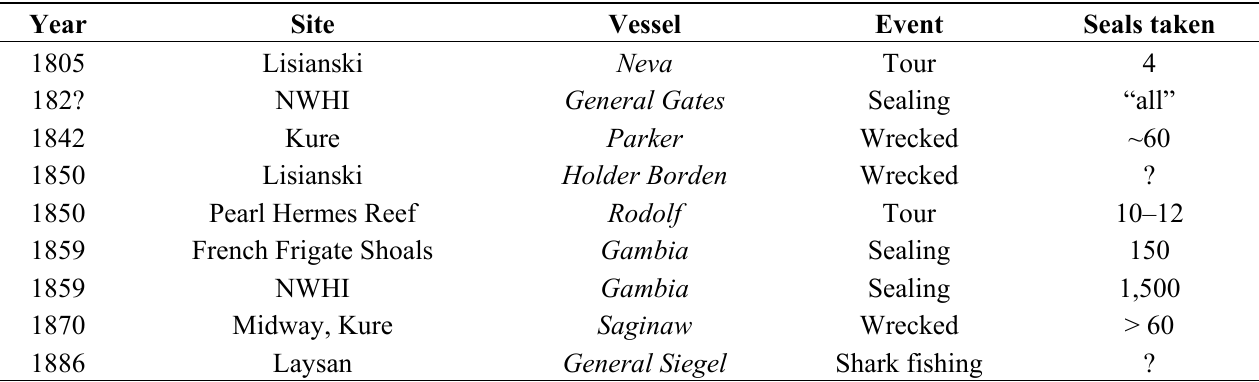
Table 1. Nineteenth century hunting of the Hawaiian monk seals, summarized from Ragen, Table 1